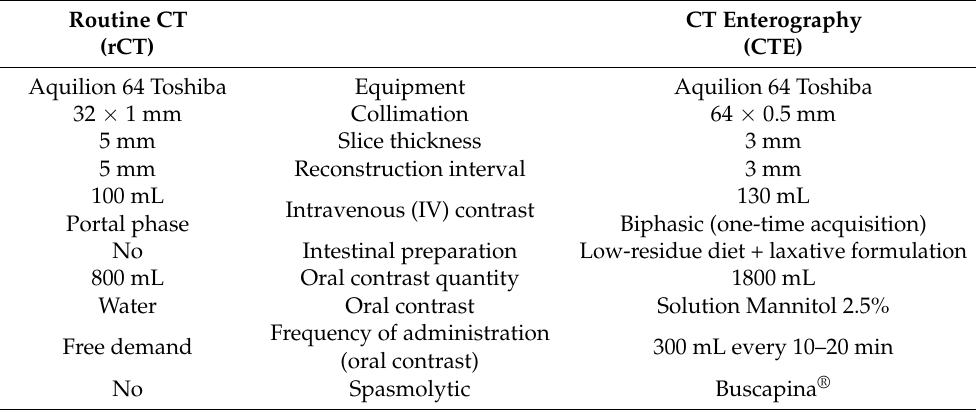
Table 2. Characteristics of the CT study